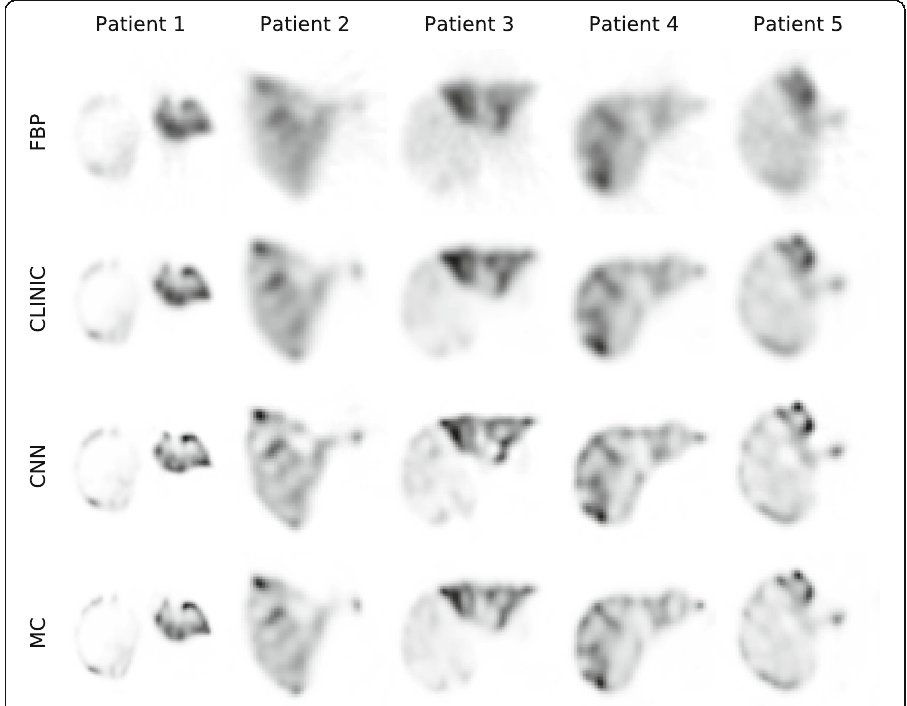
Fig. 6 Reconstruction slices of five representative distributions from the test set, for the four reconstruction